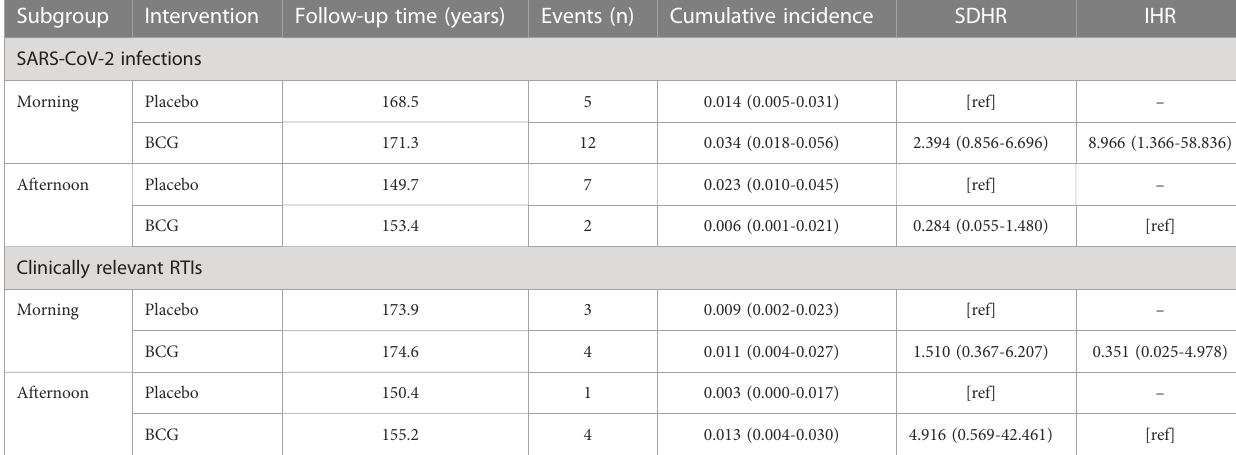
TABLE 2A Effect of morning and afternoon BCG vaccination compared to placebo in the fi rst six months after vaccination. Subgroup